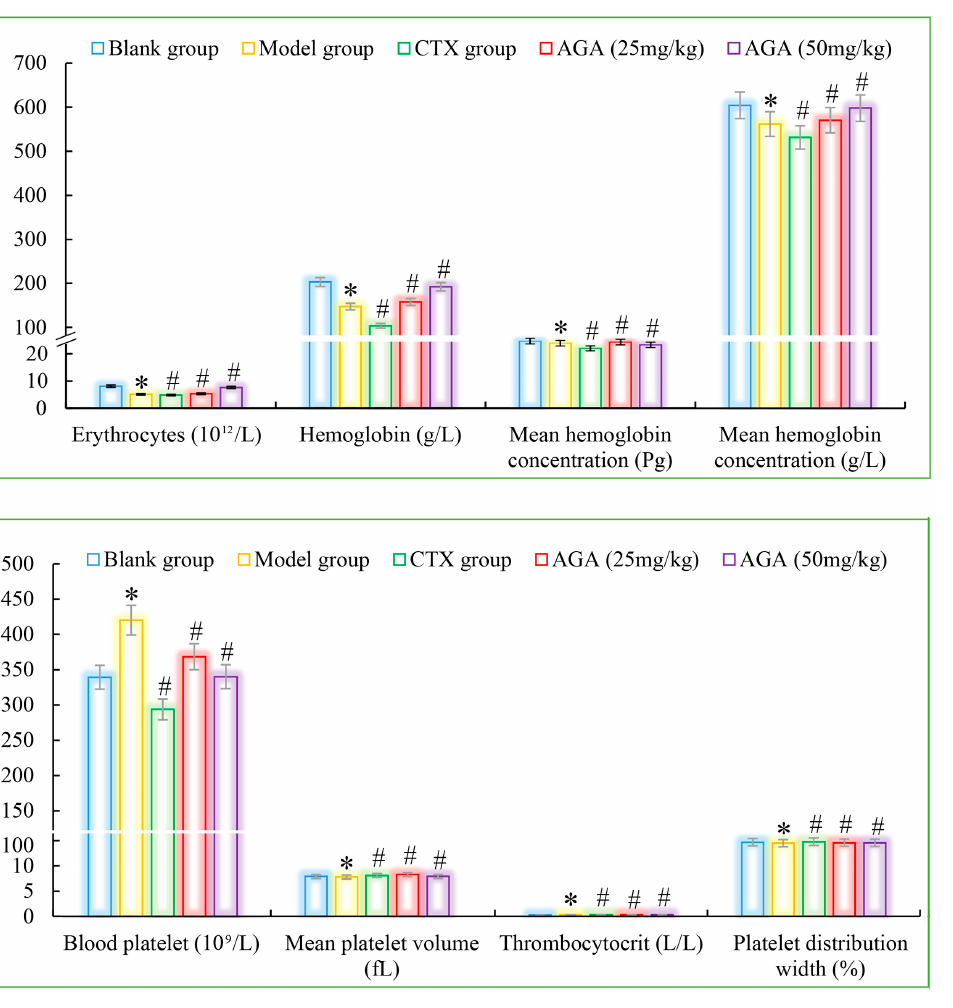
Figure 3. The blood cytokines detections of AGA on H22 tumor bearing mice. ( A ) Erythrocytes, hemoglobin, and proportion of mean hemoglobin. ( B ) Mean platelet volume, number, volume and distribution width. * p < 0.05, compared with Blank group; # p < 0.05, compared with Model group. Compared with the blank group, the number of erythrocytes, hemoglobin, lympho- cyte ratio, lymphocyte ratio, and granulocyte ratio of mice in the model group decreased significantly (Figures 3A and 4A), while the levels of blood platelets, leukocytes, and gran- ulocytes increased significantly (Figures 3B and 4B), which are all distinctive features of malignant tumors, indicating that the growth and proliferation of tumor cells cause ane- mia, severe tissue damage, and inflammation. Compared with the model group, the num- ber of erythrocytes, hemoglobin dose group mice, lymphocytes, lymphocyte ratio, and granulocyte ratio significantly increased (Figures 3A and 4A), while platelet, leukocyte, and granulocyte levels significantly decreased and were dose correlated (Figures 3B and 4B), indicating that AGA treatment could alleviate malignancy-induced adverse reactions and enhance the immune activity of H22 tumor-bearing mice. The CTX treatment group showed that cyclophosphamide could inhibit the growth of malignant tumors and allevi- ate tumor-induced adverse effects.